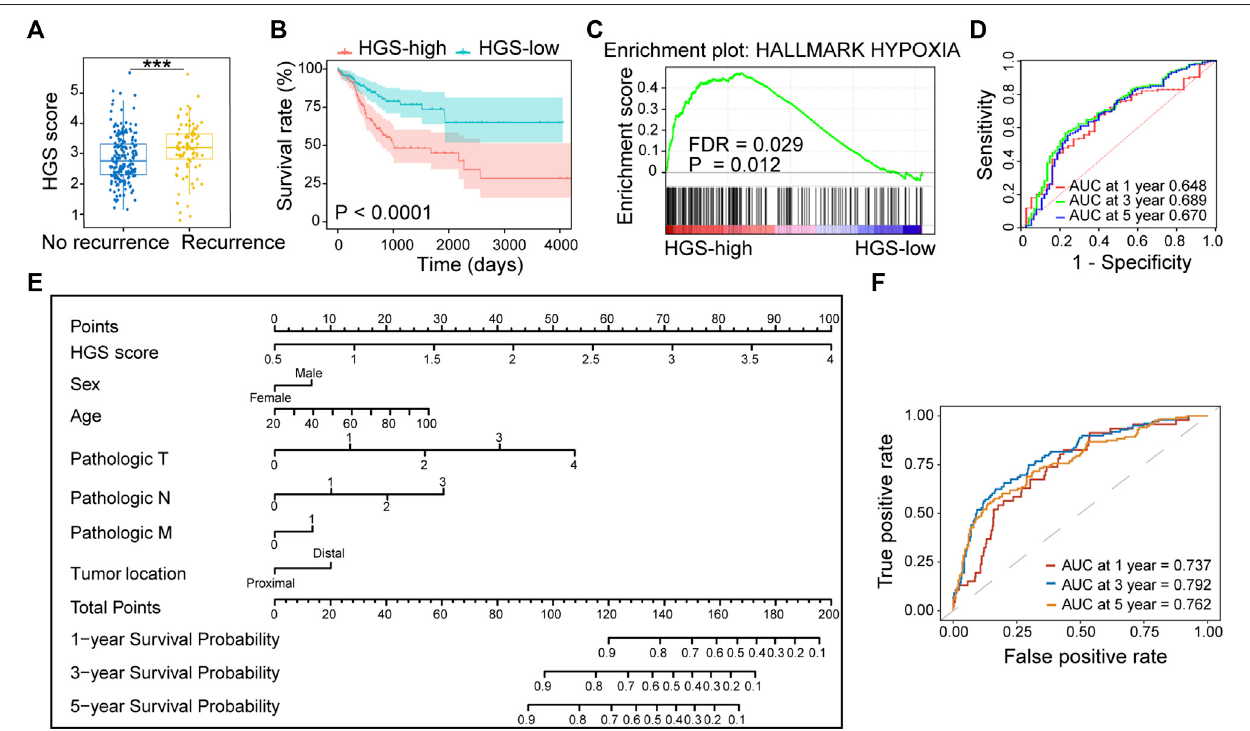
FIGURE 3 | Validation of HGS in TCGA. (A) Comparison of HGS scores in recurrence and no recurrence patients. (B) Kaplan – Meier RFS curves for patients in HGS-highandHGS-lowgroups. (C) GSEAofhypoxiapathwayinHGS-highandHGS-lowgroups. (D) Time-dependentROCcurvesat1,3and5 years. (E) Nomogram developed based on HGS and clinicopathological characteristics. (F) Time-dependent ROC curves at 1, 3 and 5 years.